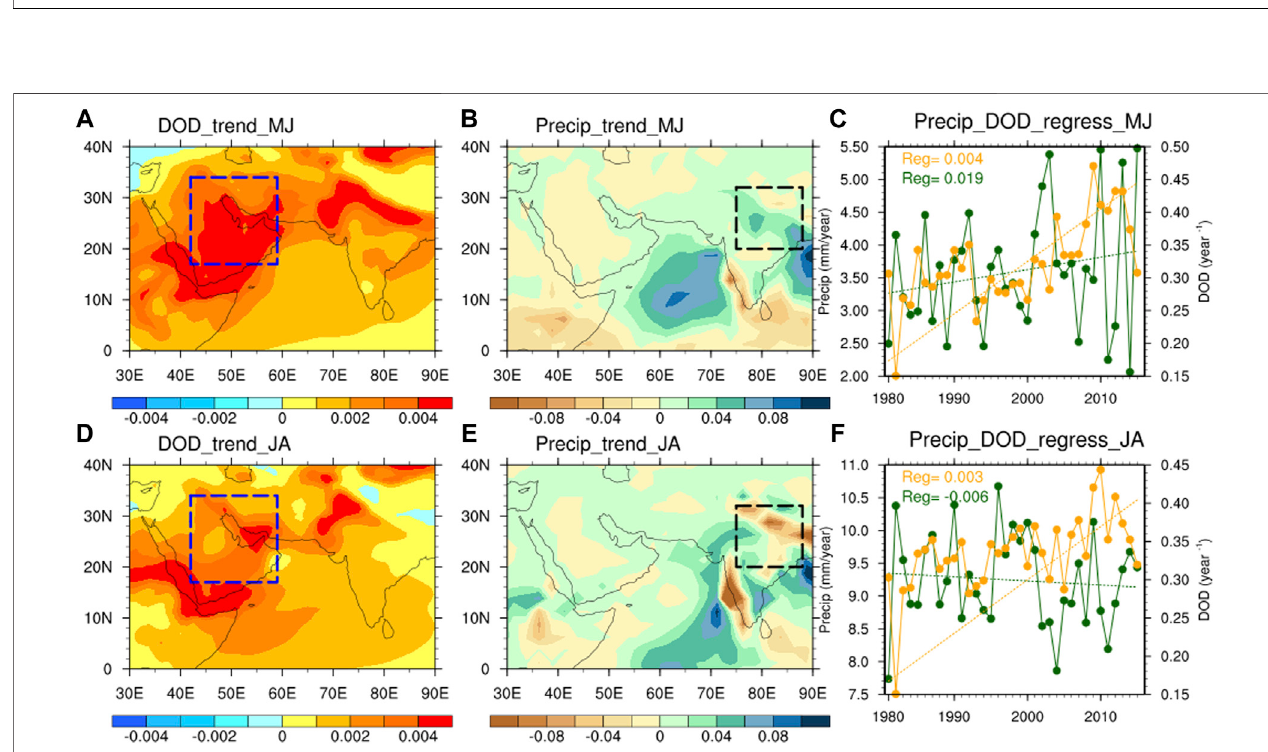
FIGURE 14 | Spatial distributions of variation trends of dust aerosol optical thickness (A,D) from MERRA-2 and precipitation from GPCP (C,E) as well as the year- to-yearvariations ofthe dustaerosolopticalthickness averagedfor theWAD(yellow) and precipitation averaged fortheCEI (green,mm/year) (C,F) intheearly monsoon (A – C) and late monsoon seasons (D – F) from 1980 – 2015. The blue dotted box represents the WAD, as shown in Figure 1 . The black dotted box represents CEI, as shown in Figure 3 .